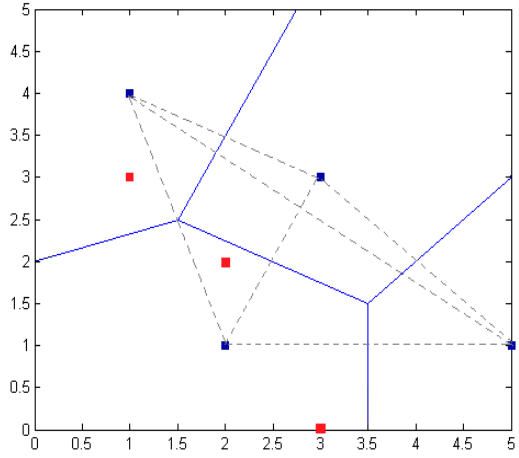
Figure 24. Sketch map of regional divisions.